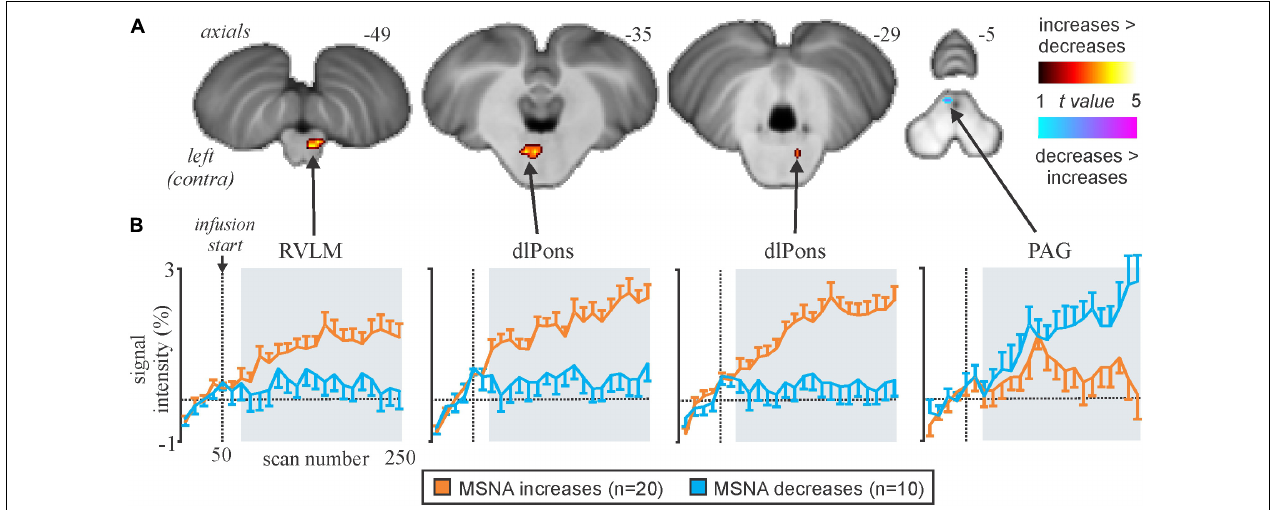
FIGURE 6 | (A) Brainstem regions in which signal intensity increases were greater (hot color scale) or lower (cool color scale) in the increasing MSNA ( n =20) compared with the decreasing MSNA ( n =10) group during tonic muscle pain. Significant clusters were overlaid onto a mean SUIT T1-weighted anatomical image set created from 30 subjects. (B) Plots of mean ( ± SEM) percentage signal intensity changes during pain relative to the baseline period for significant clusters in the increasing MSNA (orange) and decreasing MSNA groups (blue). RVLM, rostroventrolateral medulla; dlPons, dorsolateral pons; PAG, midbrain periaqueductal gray. Reproduced, with permission, from Kobuch et al.